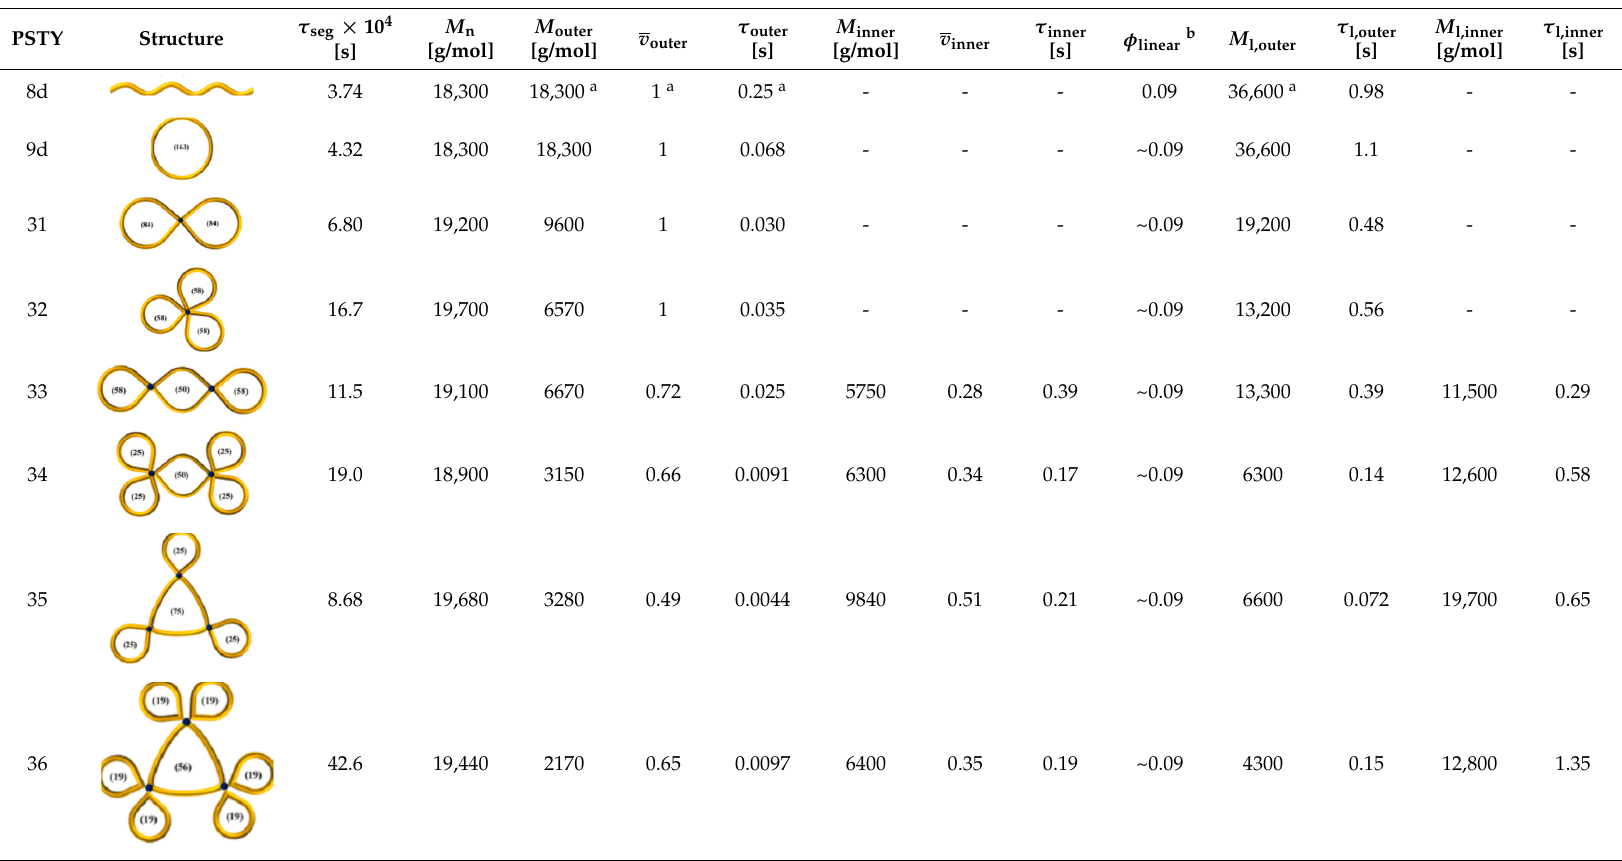
Table 1. Molecular characteristics and dynamic properties of multicyclic polystyrenes at 403 K.